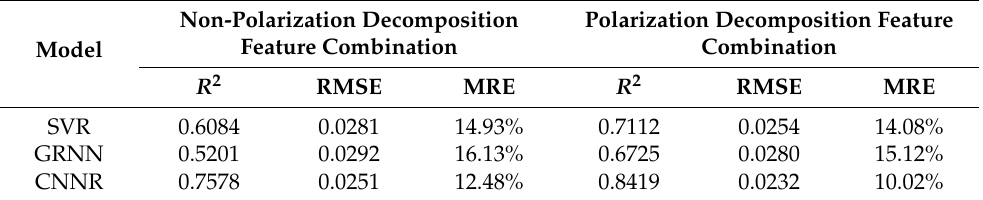
Table 4. Comparison of the average of SVR, GRNN, and CNN under six selected